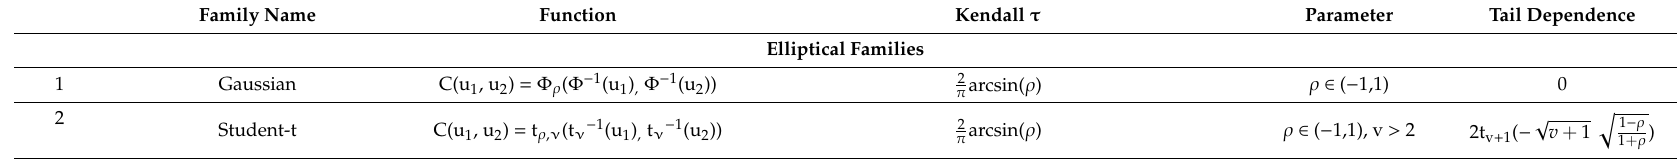
Table 2. Description of Copula